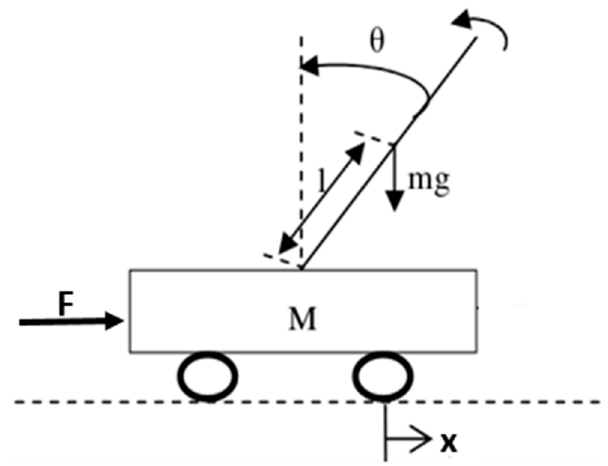
Figure 5. Inverted pendulum system.